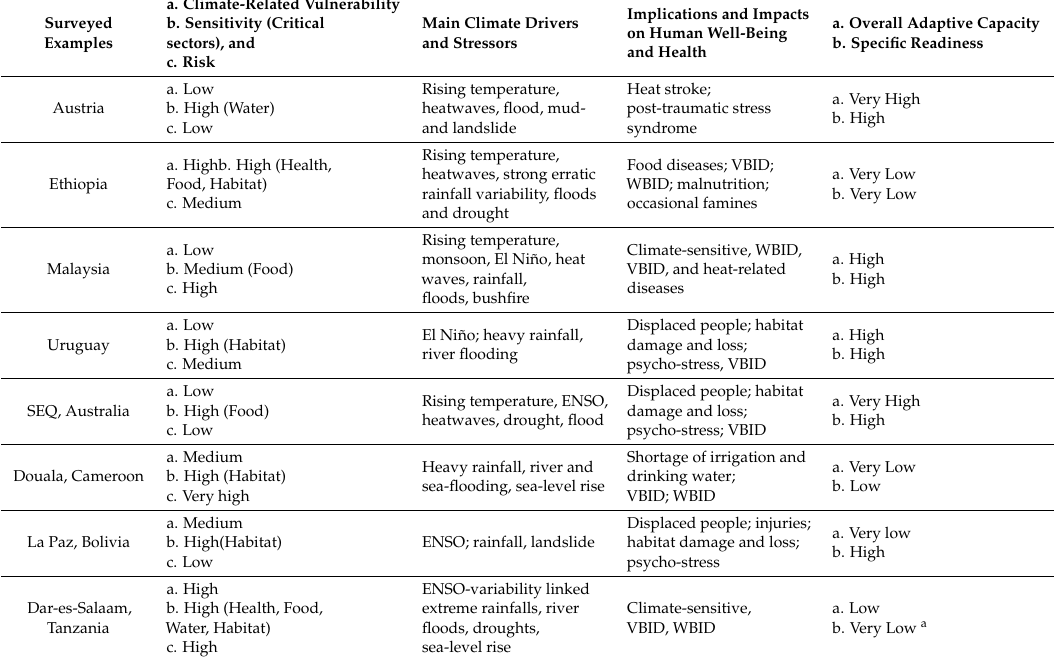
Table 3. Summary of climate-related overall vulnerability and sensitivity (critical sectors), climate stressors, implications and health impacts, and overall adaptive capacity and specific readiness in the case studies examined. The main climate stressors are based on Table 1 and the development, vulnerability, adaptive capacity statuses are based on Table 2 and issues presented in the surveyed examples. The sensitivity is equally weighted and averaged. Vector-borne and water-borne infectious diseases: VBID and WBID, respectively.